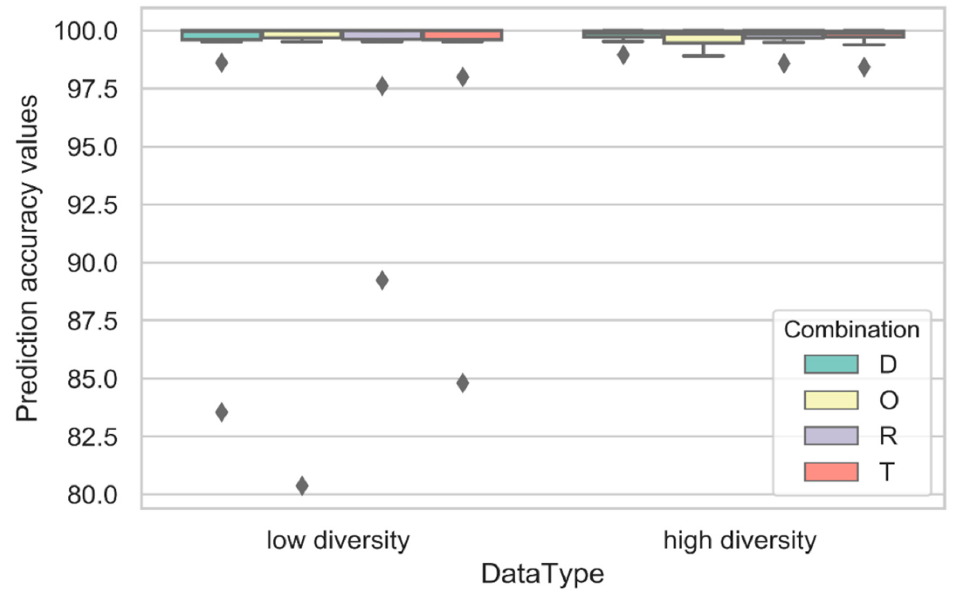
Figure 8. A comparison of the prediction accuracies for the D, O, R, and T combination cases, plotted using the boxplot charts.